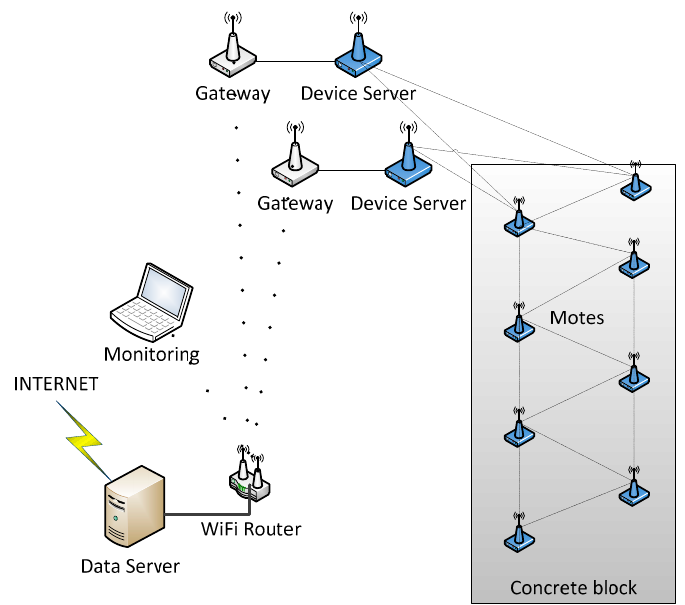
Figure 6. Scheme of the monitoring system based on the wireless sensor network.